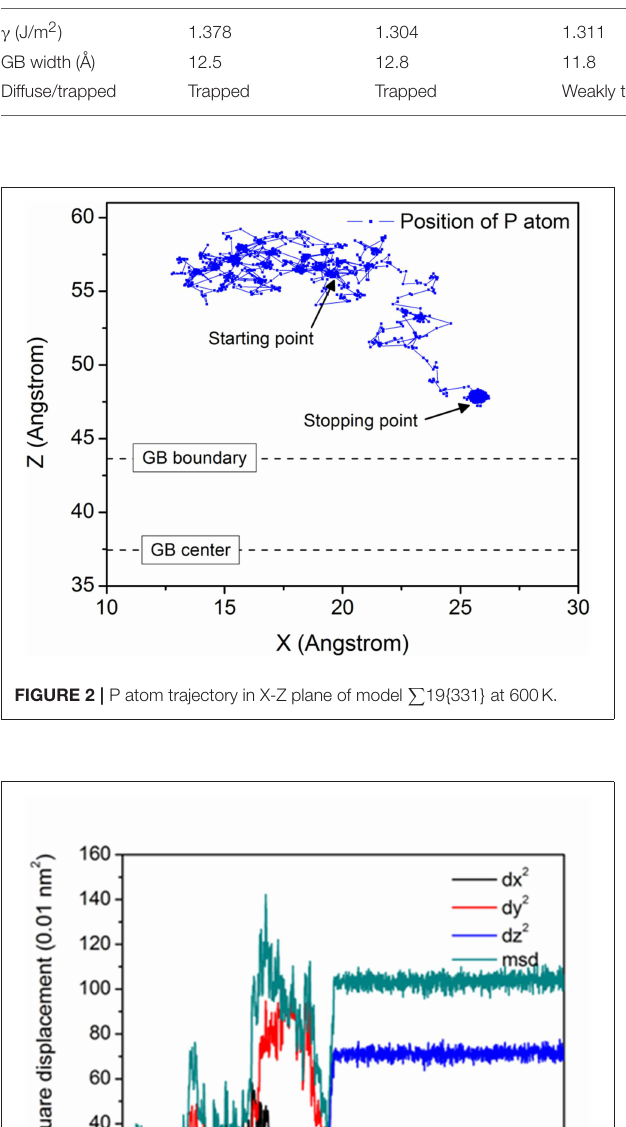
diffusion at the GB boundary in Figure 3 . The plateau after 1 ns represents the transition of interstitial P to substitutional P at the stopping point which is evident by the visual